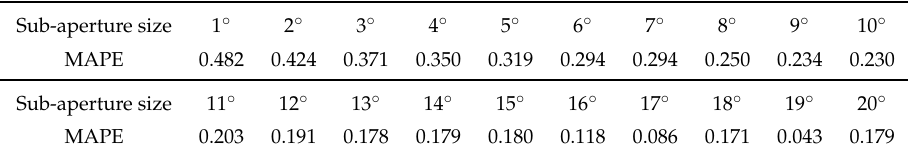
Table 3. MAPE of the dihedral with different sizes of